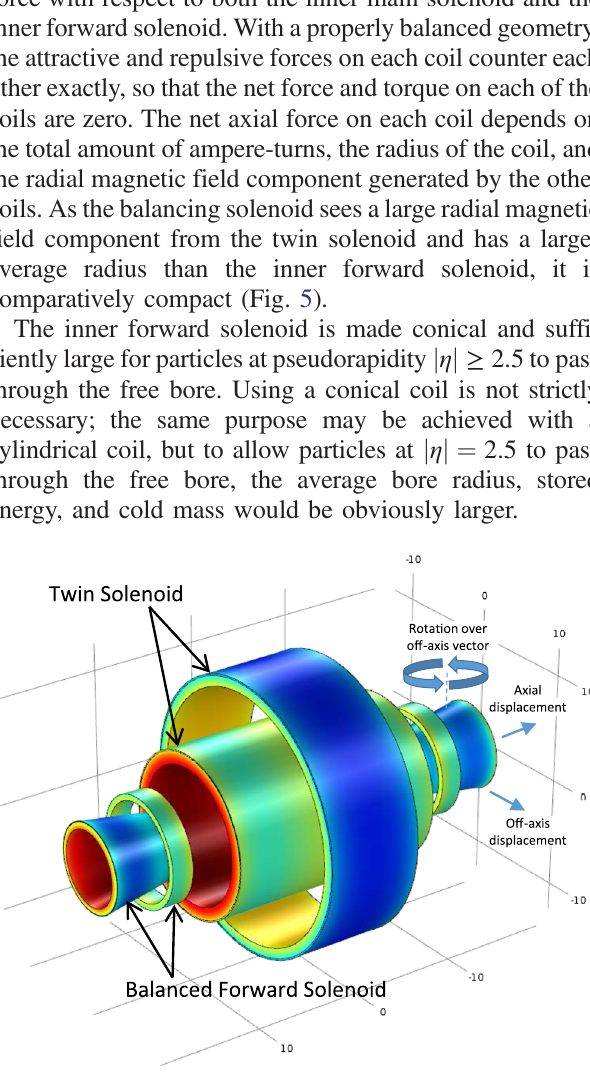
FIG. 4. Three-dimensional representation of the superconduct- ing coils of the twin solenoid and the two balanced forward solenoids. The color indicate the magnetic field on the surfaces of the cold masses, also see Fig. 5. The blue arrows illustrate the various possible misalignments of the cold mass as discussed in Sec.